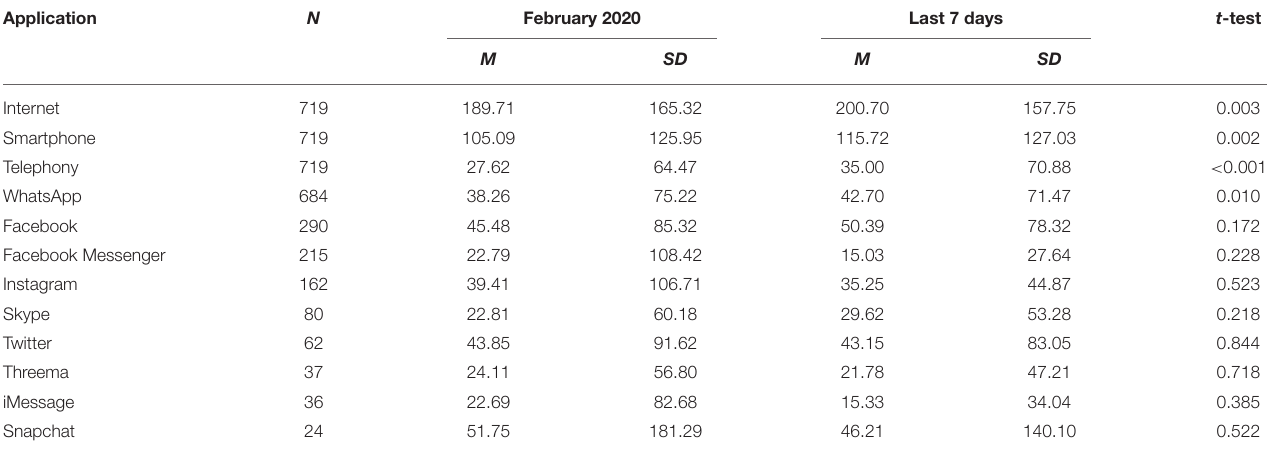
TABLE 1 | Means (M) and standard deviations (SD) of using times per different social networks and online communication applications as well as the smartphone and Internet use in general. Application